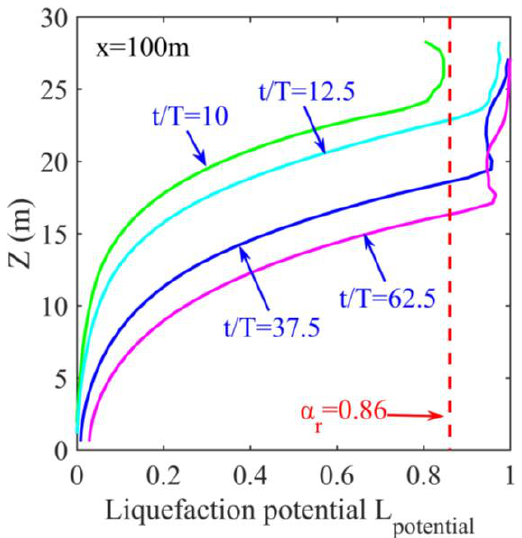
Figure 8. Vertical distribution of the liquefaction potential L potential at typical times t / T = 10, 12.5, 37.5, and 62.5.